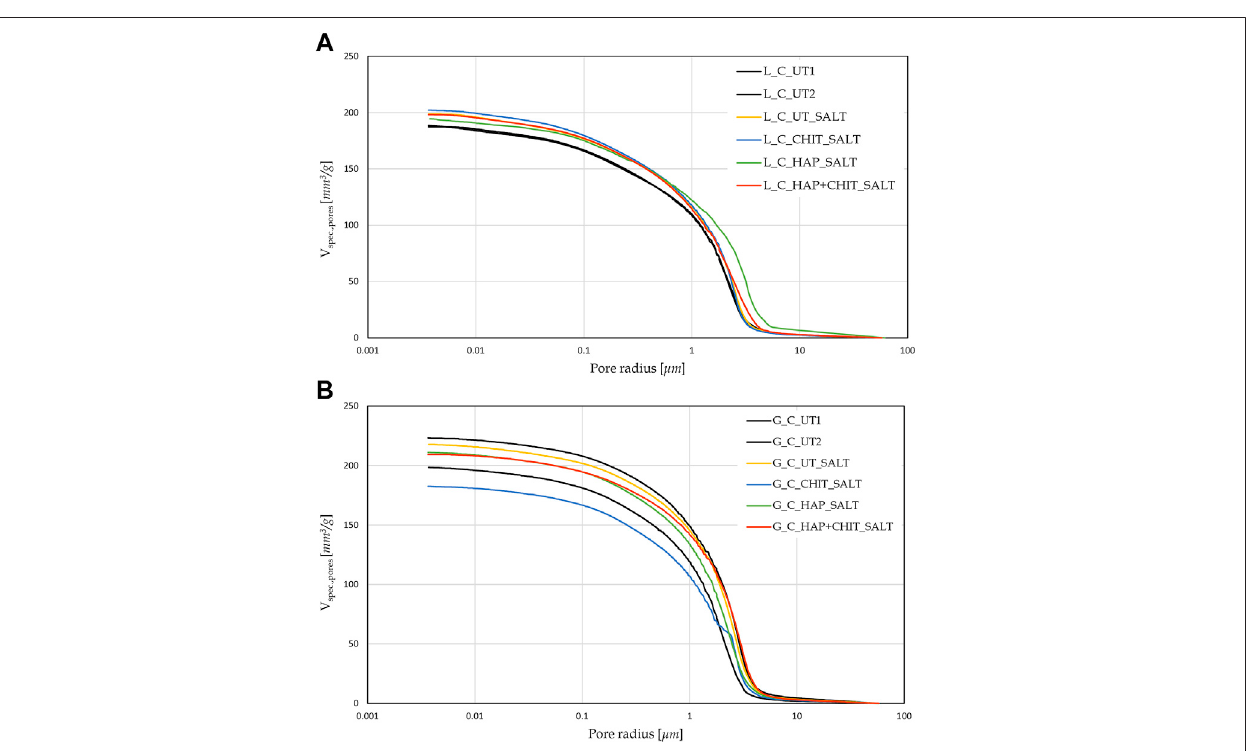
FIGURE7| Poresizedistribution ofstonesamples,obtainedwithMIPtest,after thesalt crystallization test(anddesalination bypoulticing)for: (A) Leccestoneand (B) Globigerina limestone.